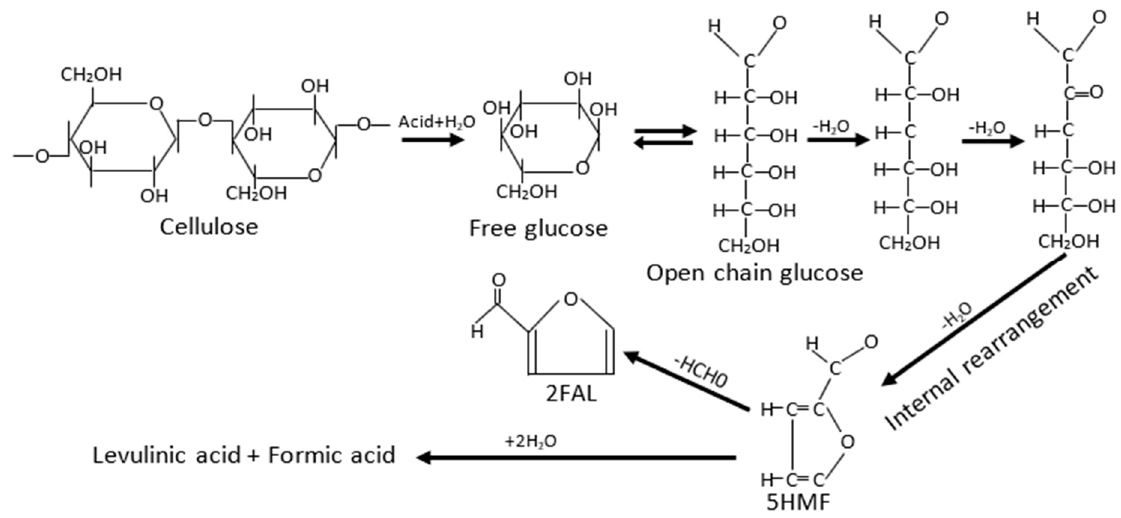
Figure 2. Hydrolysis mechanism in